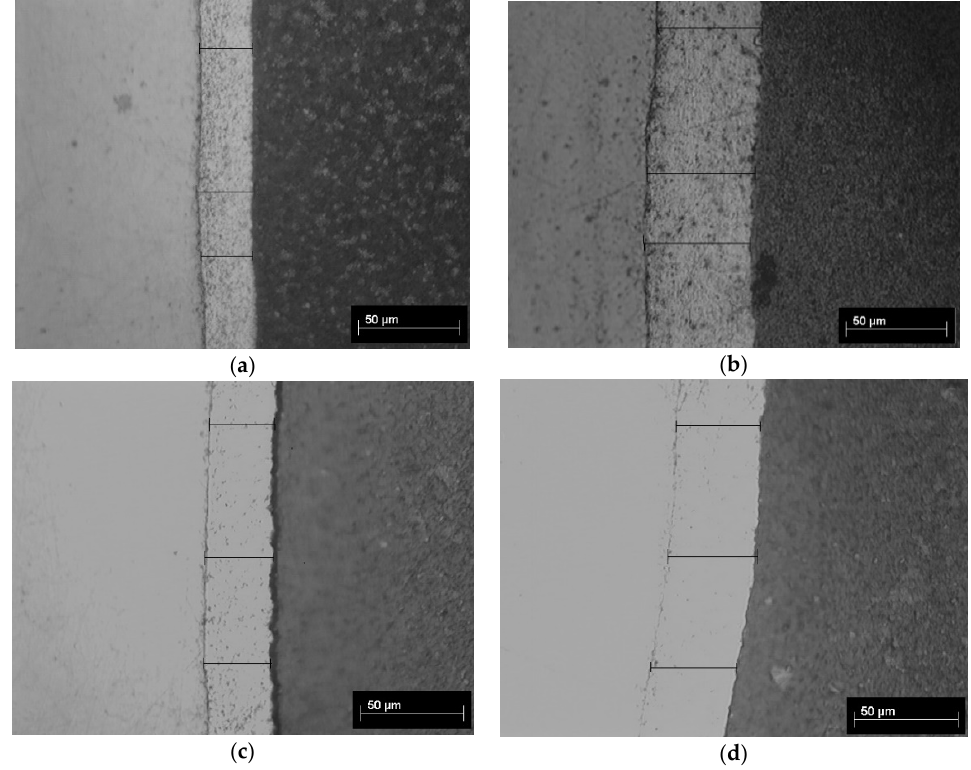
Figure 2. Cross-section images obtained with optical microscopy showing the thickness of epoxy resin/zinc hybrid coatings: ( a ) sample A; ( b ) sample B; ( c ) sample C; ( d ) sample D. Magnifica- tion: 500 ×